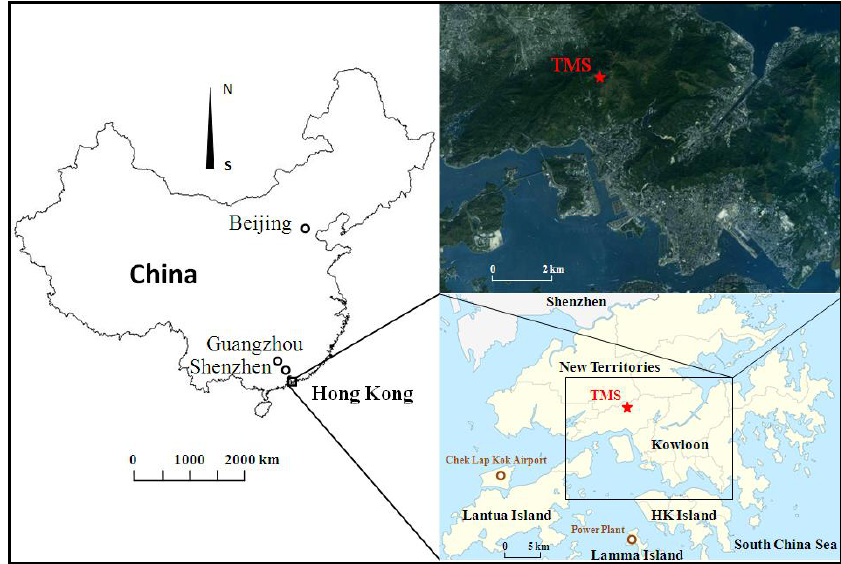
Fig. 1. Locations of Hong Kong and the TMS sampling